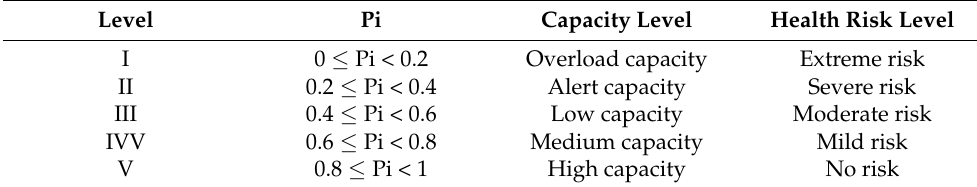
Table 2. Comprehensive evaluation of the soil quality in the Pearl River Basin. Level Pi Capacity